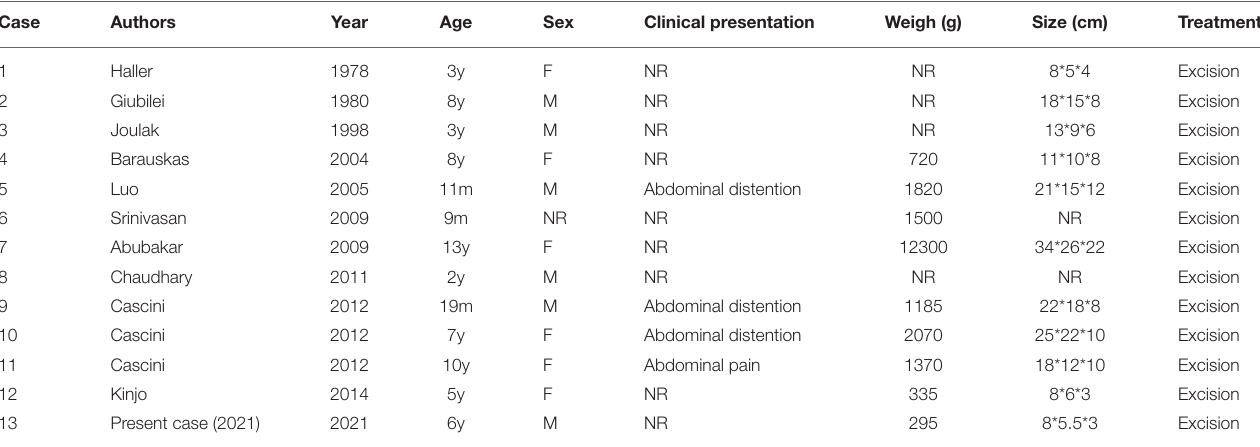
TABLE 1 | Cases of children reported to have omental lipoma found in the available